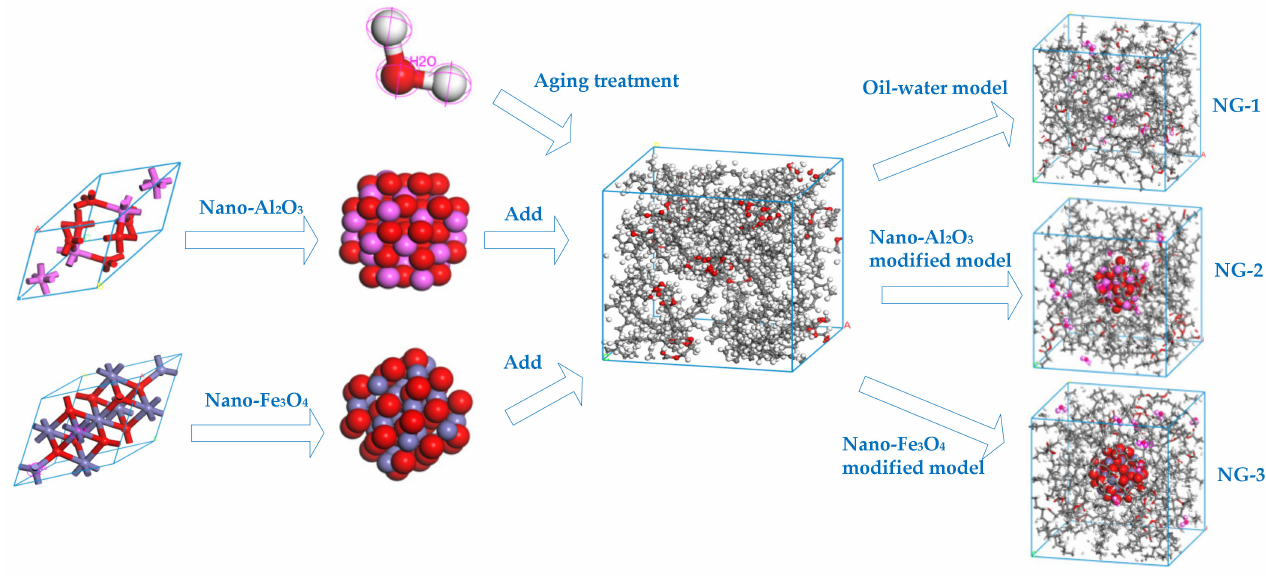
Figure 5. Construction process of the computational models before and after